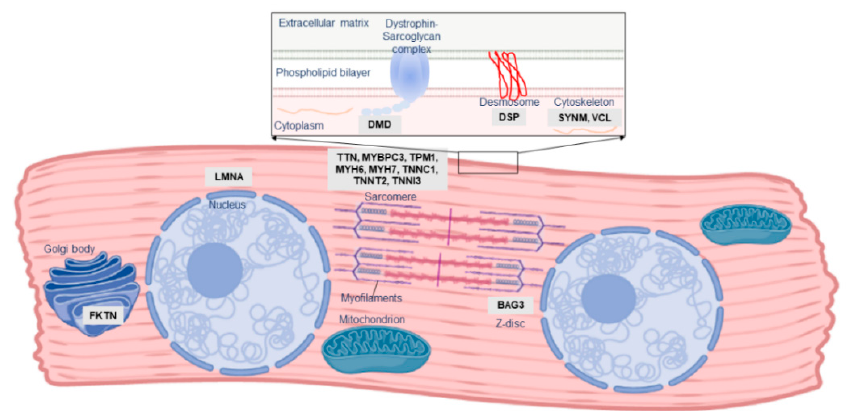
Figure 2. Localisation and function of PPCM-associated genes in the cardiomyocyte. The majority of PPCM genes, including Titin ( TTN ), comprise the cardiac sarcomere, but mutations affecting numerous other aspects of cardiomyocyte function have been implicated in PPCM pathogenesis.